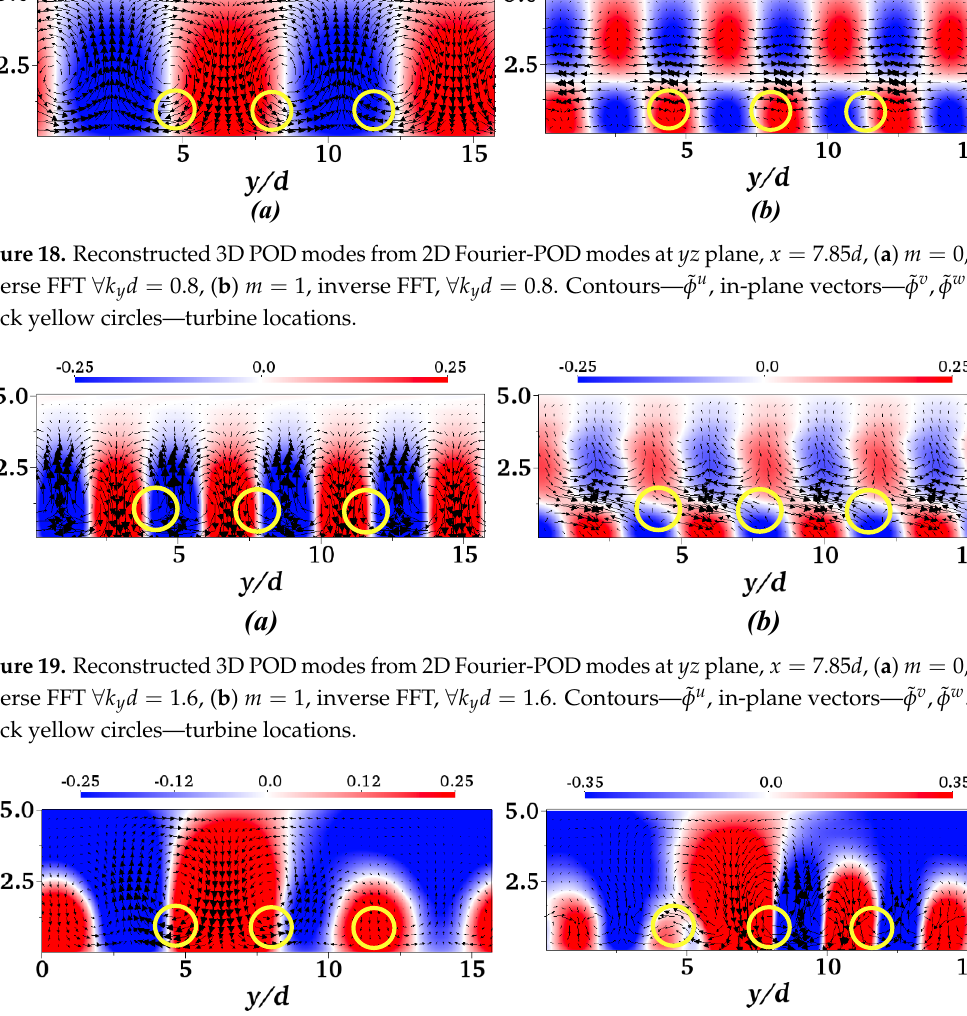
Figure 20. Reconstructed 3D POD modes from 2D Fourier-POD modes at yz plane, x = 7.85 d , k y d = 0 ( a ) m = 0, inverse FFT 1.2, ( b ) m = 0, inverse FFT, ∀ − vectors— ˜ φ v , ˜ φ w . Thick yellow circles–turbine